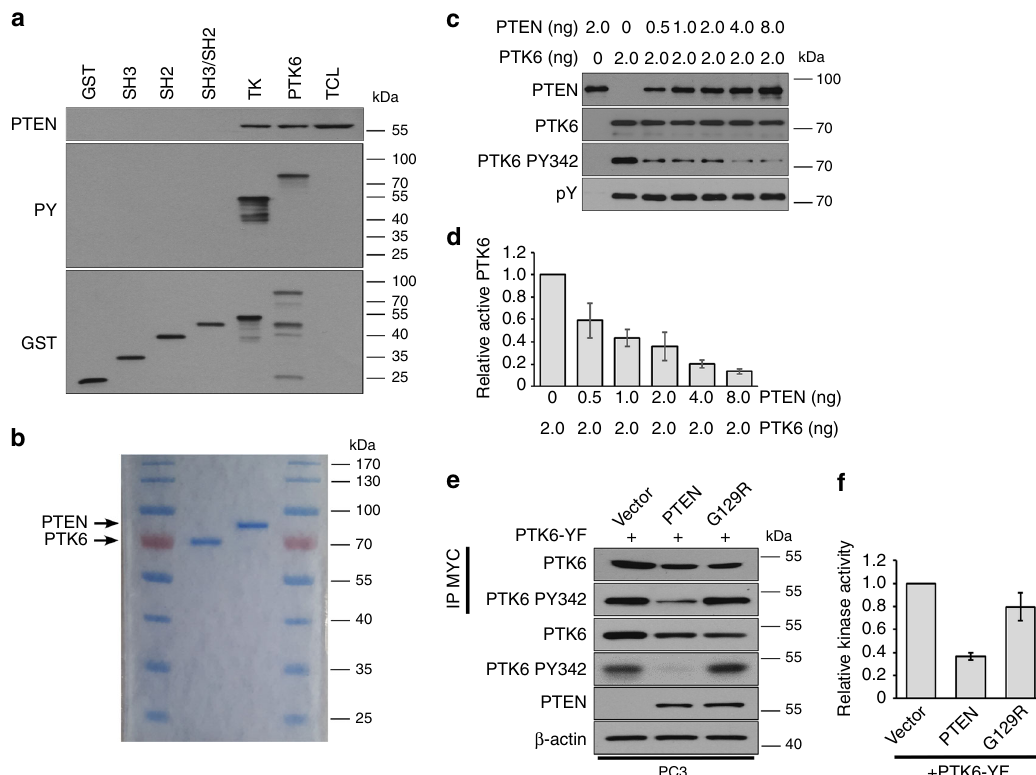
Fig. 3 PTEN inhibits PTK6 kinase activity. a Glutathione beads were used to pull down GST-tagged PTK6 domains incubated with DU145 cell lysates. Bound PTEN protein was observed by immunoblot. b Full-length human PTEN and full-length human PTK6 were expressed in E. coli and puri fi ed using glutathione beads. Eluted protein was subjected to SDS – PAGE and visualized by Coomassie staining to evaluate purity. c Puri fi ed GST-tagged PTEN and PTK6 were used in an in vitro phosphatase assay. Residual activating phosphorylation of PTK6 was monitored by immunoblotting. d Quanti fi cation of in vitro phosphatase assays. Data represent three independent experiments run in triplicate. Error bars denote standard error. e MYC-tagged constitutively-active PTK6 (PTK6-YF) was immunoprecipitated from PC3 cell expressing empty vector, PTEN, or PTEN G129R. f Immunoprecipitated PTK6-YF was used in an in vitro kinase assay. Kinase activity was recorded using an anti-phospho-tyrosine antibody linked to horseradish peroxidase (HRP) in the presence of